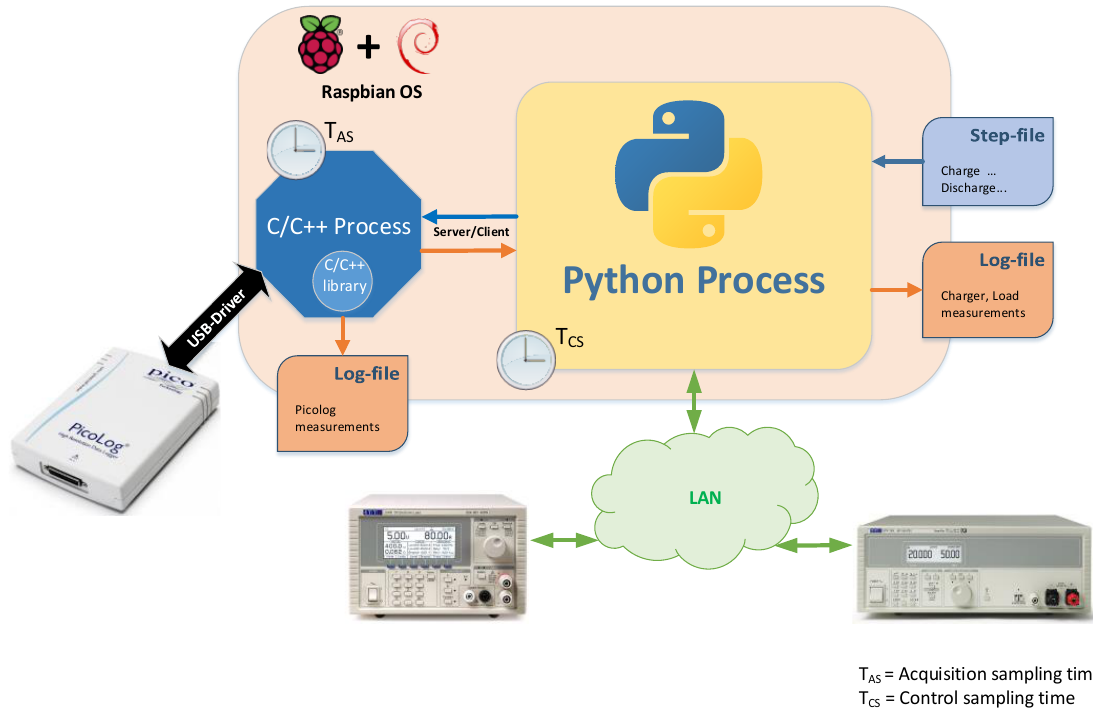
Figure 3. Software framework of the Cell Station Tester.